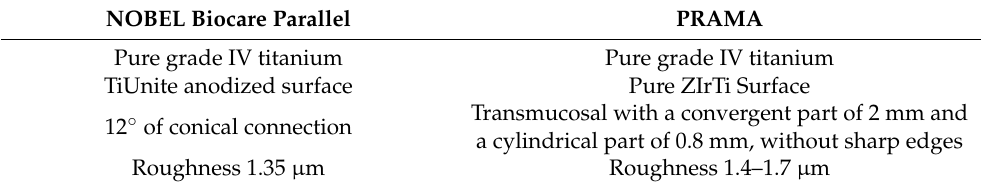
Table 2. Main implant